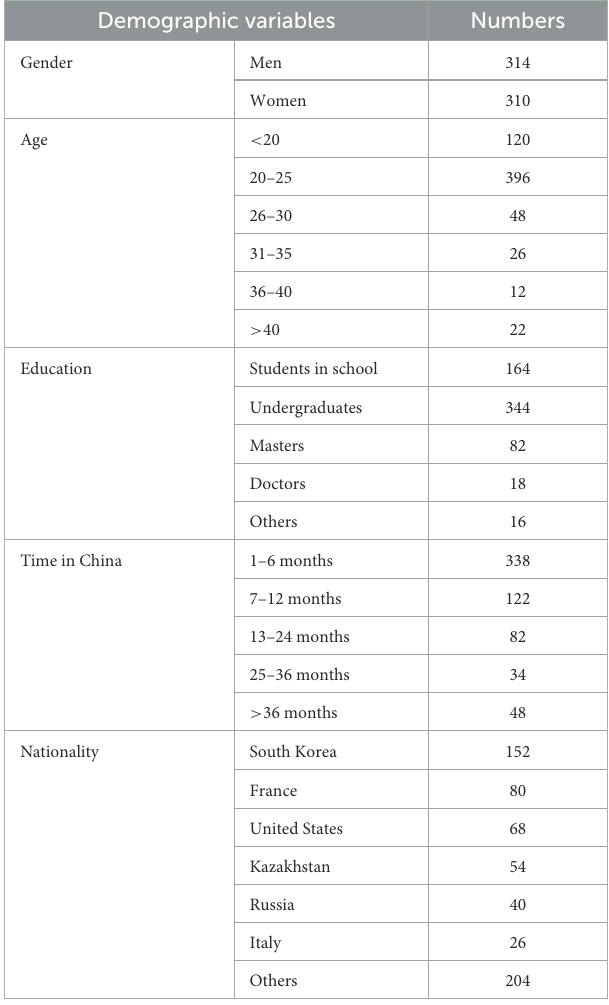
TABLE 1 Demographic characteristics of the